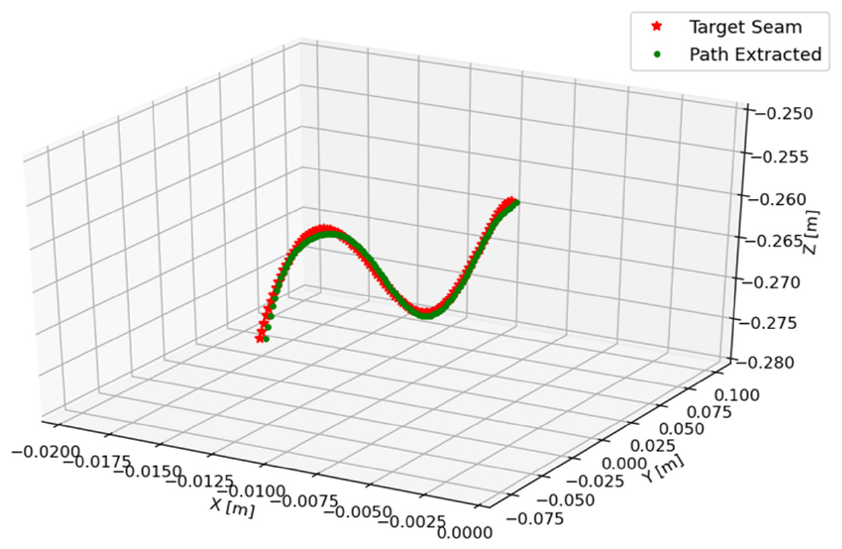
Figure 9. Workpiece target path vs. computed trajectory.